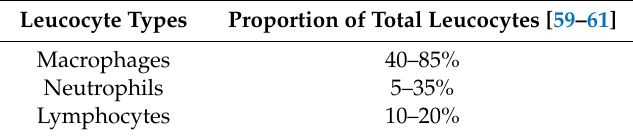
Table 1. Types of leucocytes present in milk of healthy